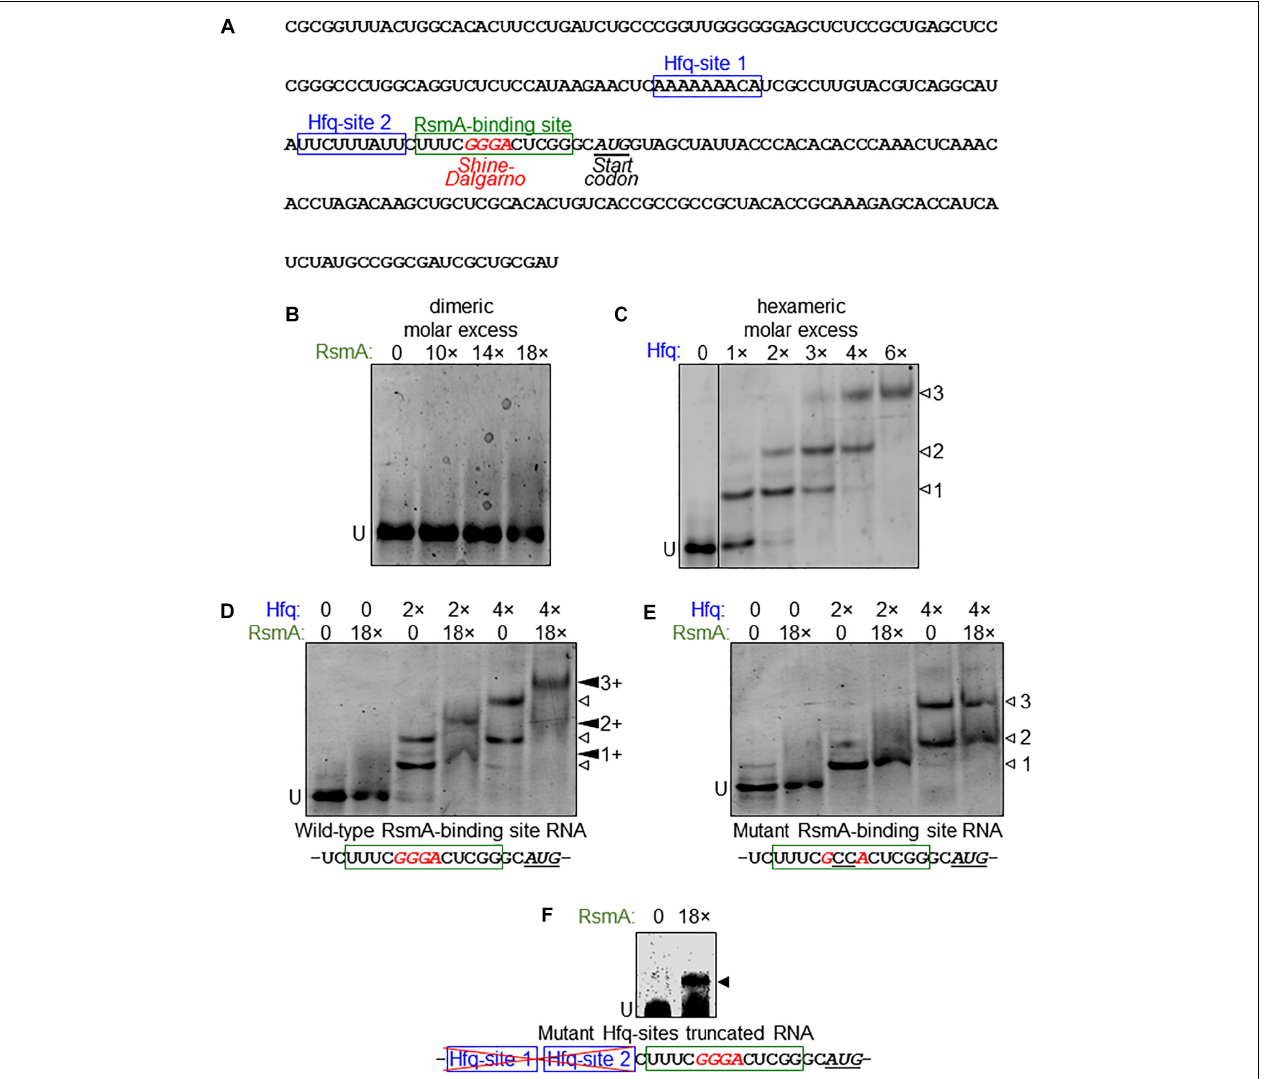
FIGURE 4 | Direct binding of vfr mRNA by RsmA requires Hfq. (A) Sequence of the vfr RNA used in electrophoretic mobility shift assay (EMSA) experiments are shown, spanning from the transcriptional start and partially through the vfr open reading frame (ORF). The leader sequence of the vfr transcript (Fuchs et al., 2010) possesses two putative Hfq-binding sites (blue boxes) and a RsmA-binding site (green box) overlapping the predicted Shine–Dalgarno sequence (red italics) upstream of the translational start site (underlined italics). (B) RNA EMSA shows that RsmA does not bind to the vfr RNA when RsmA is present alone. Dimeric molar excess relative to RNA; U, unbound RNA. (C) The vfr RNA produces three distinct band shifts (open arrowheads 1, 2, and 3) with increasing concentrations of Hfq. Hexameric molar excess relative to RNA. (D) The presence of RsmA causes all Hfq-shifted bands to super-shift (filled arrowheads 1+, 2+, and 3+), indicating that RsmA binds to Hfq-bound RNA. Note that the RsmA concentration used (18 molar excess of RNA) is incapable of producing a shift when present alone (B) . (E) A GG → CC substitution within the RsmA-binding site abolishes RsmA super-shifts but does not alter Hfq binding. (F) RsmA can bind to the truncated form of the vfr RNA that lacks the region immediately upstream of the RsmA-binding site that encompasses the two Hfq-binding sites. Note that this indicates removal of an inhibitory structure that otherwise blocks RsmA binding unless counteracted by binding of Hfq.